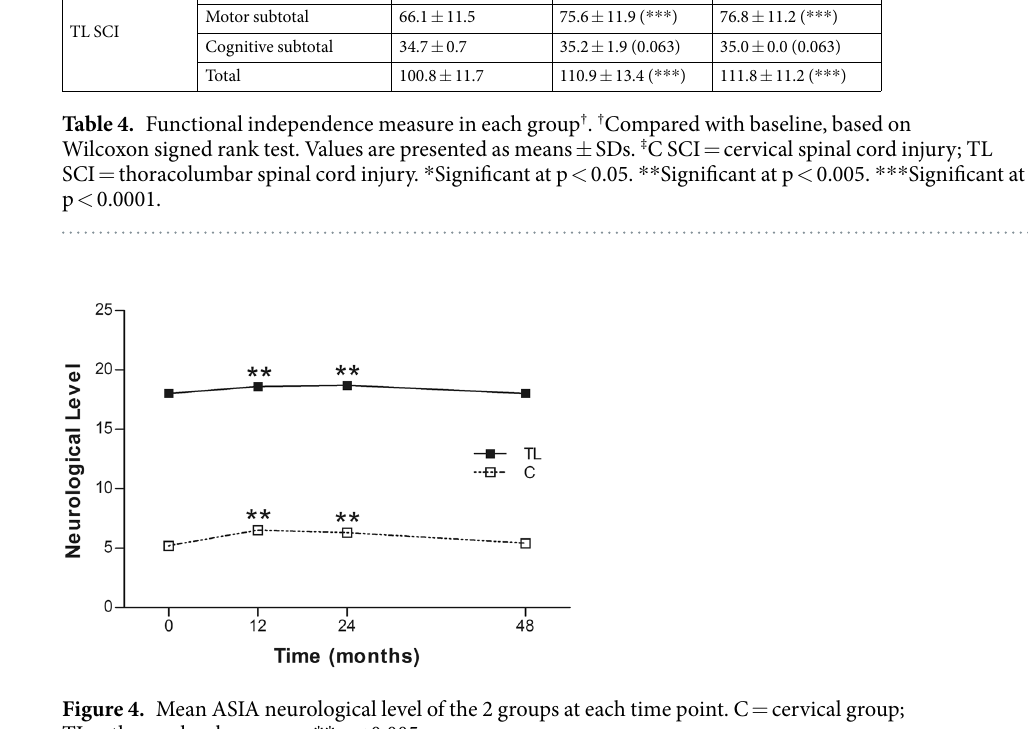
Figure 4. Mean ASIA neurological level of the 2 groups at each time point. C = cervical group; TL = thoracolumbar group; ** p < 0.005.